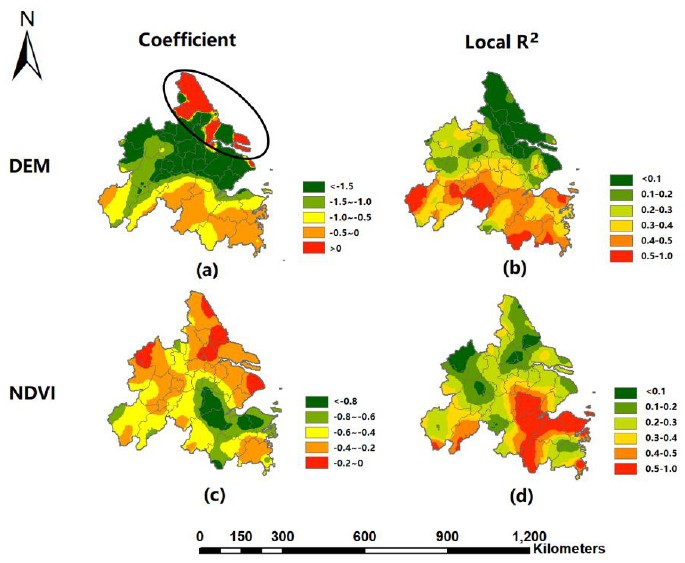
Figure 4. Spatial distribution of coefficients and local R 2 of DEM ( a , b ) and NDVI ( c , d ) by GWR in the YRD.